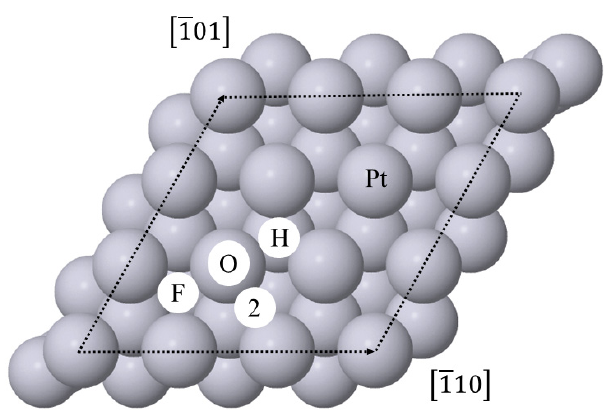
Figure 9. The ‘O’ on-top, ‘F’ FCC, ‘H’ HCP and ‘2’ two-fold bridge high-symmetry binding positions on the Pt(111) surface. The dashed lines show the (3 × 3) surface unit cell used in the current simulations.